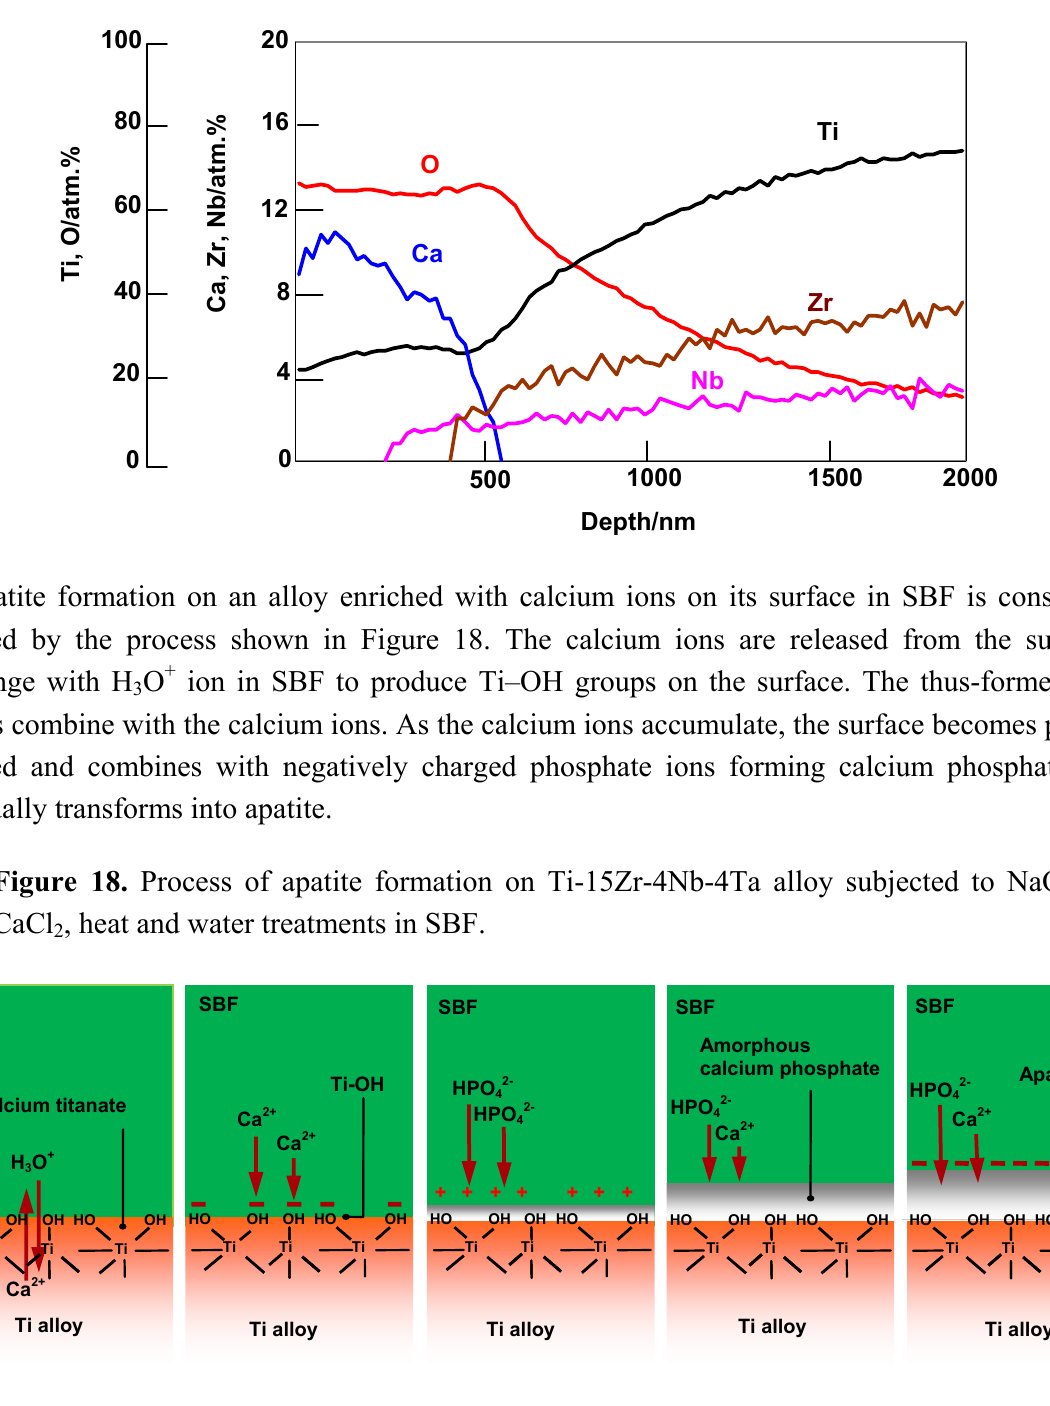
Figure 17. AES depth profiles of the surface of Ti-15Zr-4Nb-4Ta alloy subjected to NaOH, , heat and water treatments. CaCl 2